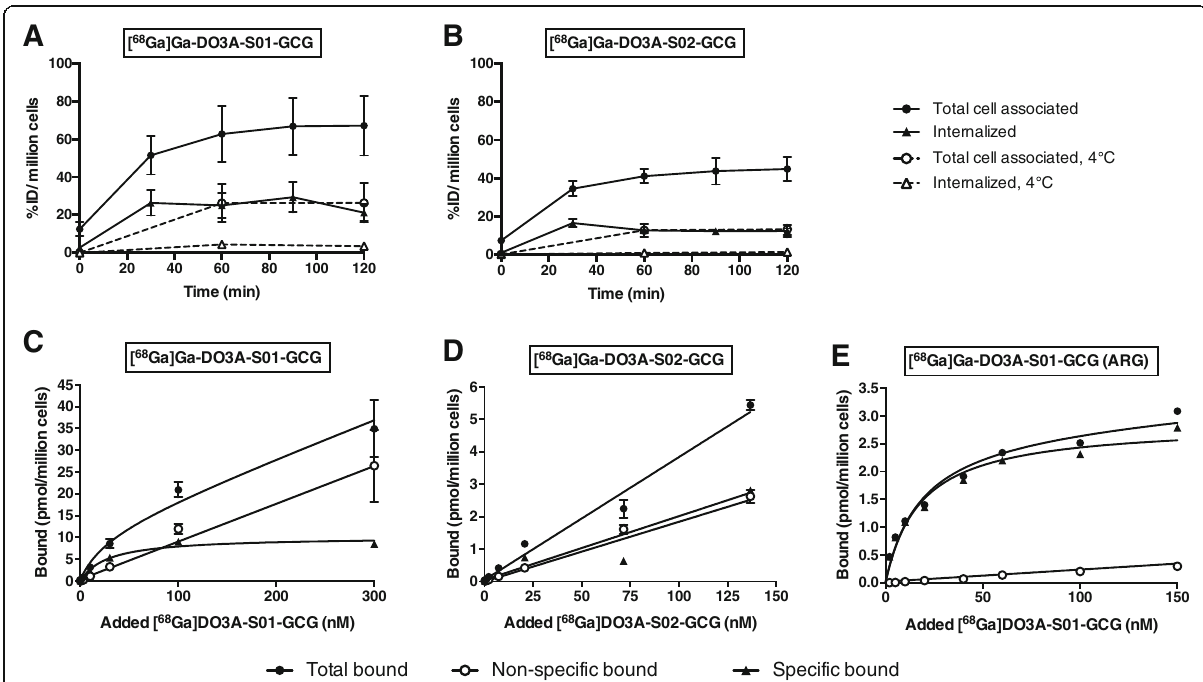
Fig. 2 Cellular internalization and GCGR affinity of [ 68 Ga]Ga-DO3A-S01-GCG and [ 68 Ga]Ga-DO3A-S02-GCG. Binding and internalization in HEK293 cells overexpressing human GCGR of [ 68 Ga]Ga-DO3A-S01-GCG ( a ) and [ 68 Ga]Ga-DO3A-S02-GCG ( b ). Internalization was suppressed by cooling cells to 4 °C. Affinity was measured in HEK293 cells overexpressing human GCGR by saturation binding studies on viable cells ( c , d ) or by in vitro autoradiography (ARG) on sections of cell pellet ( e